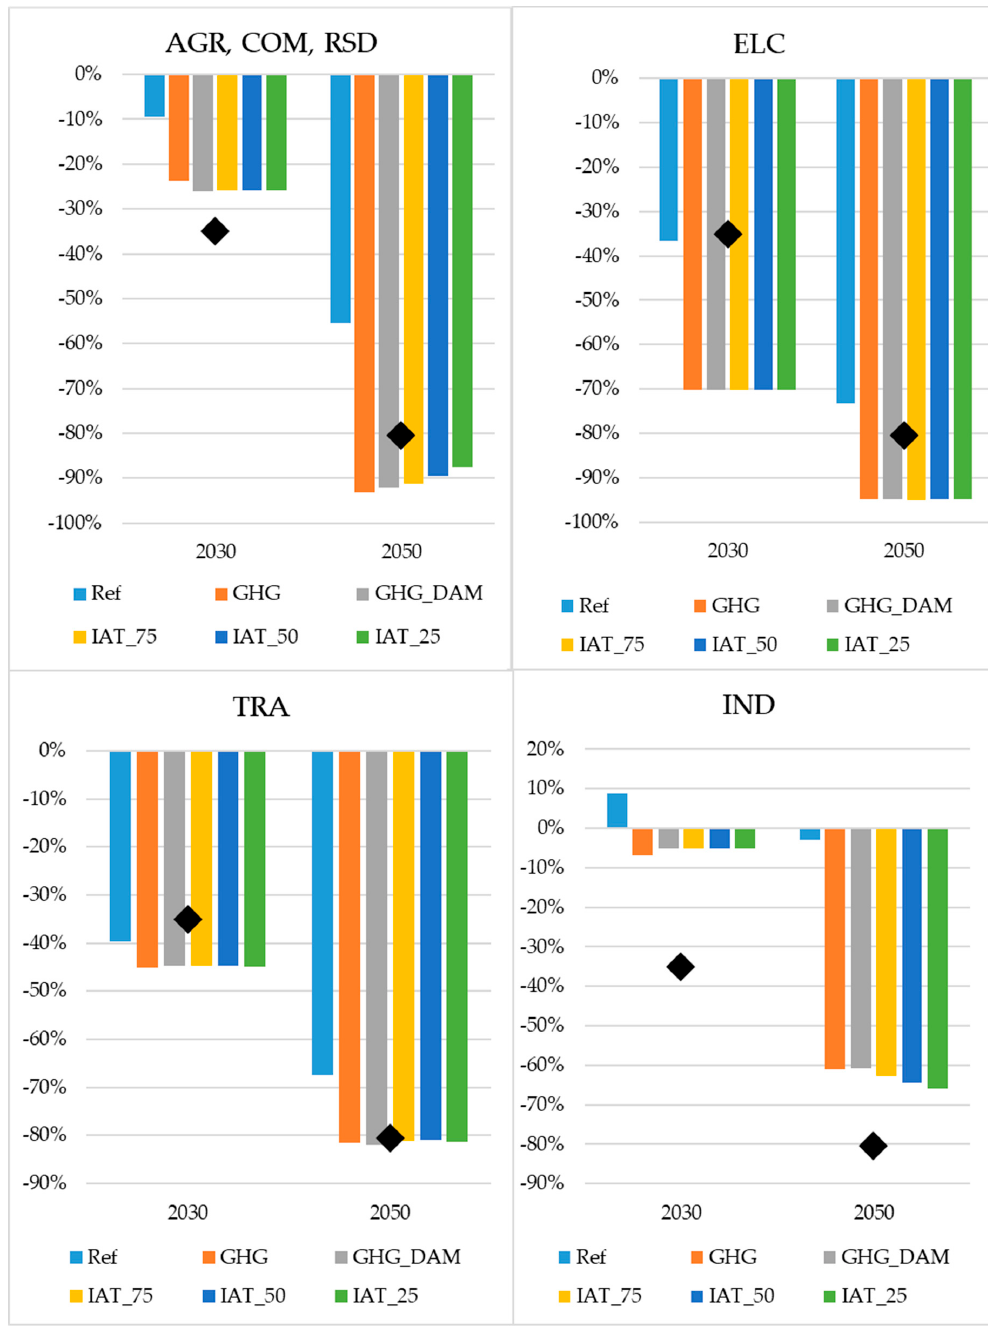
Figure 13. Sectoral CO 2 emission reductions relative to 2015 emissions in the EU28 (black squares refer to the relative CO 2 reduction targets according to 2015 level to be achieved in 2030 and 2050). With the link to NEWAGE, industry further reduces its emission due to reduced demand.